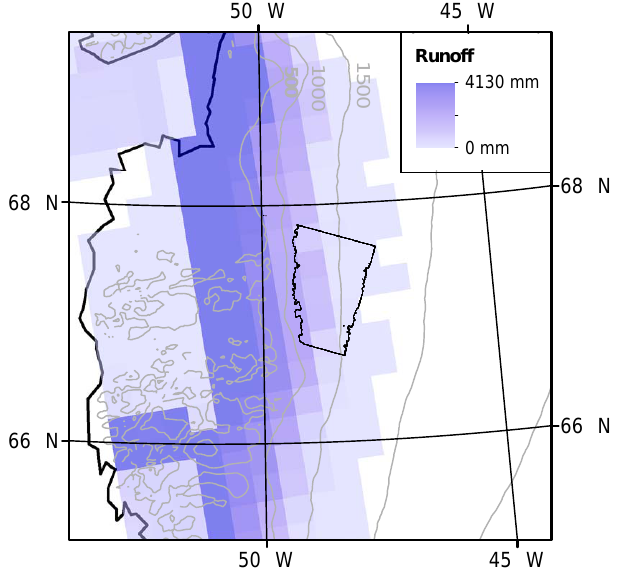
Fig. 1. Map of Greenland showing elevation contours (Bamber et al., 2001) at 500m intervals from 500m. MAR-simulated total runoff for 2003 is shown in blue (white areas represent zero runoff) and the DEM used in this study is bounded in